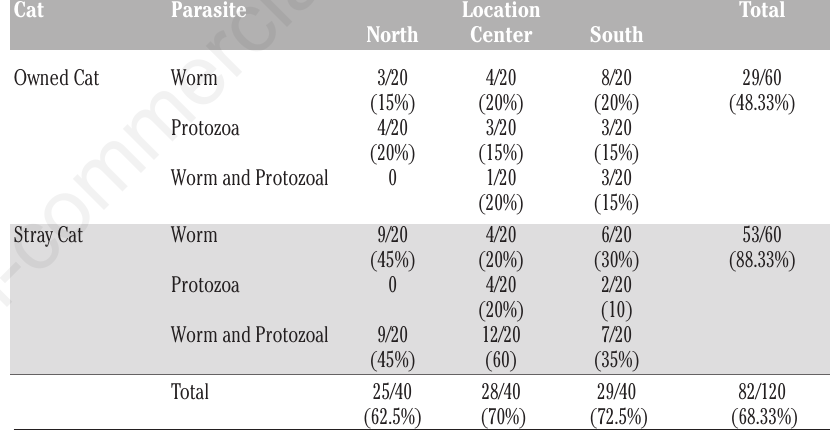
Table 1. The prevalance of infections with gastrointestinal parasites in faecal examined cats.